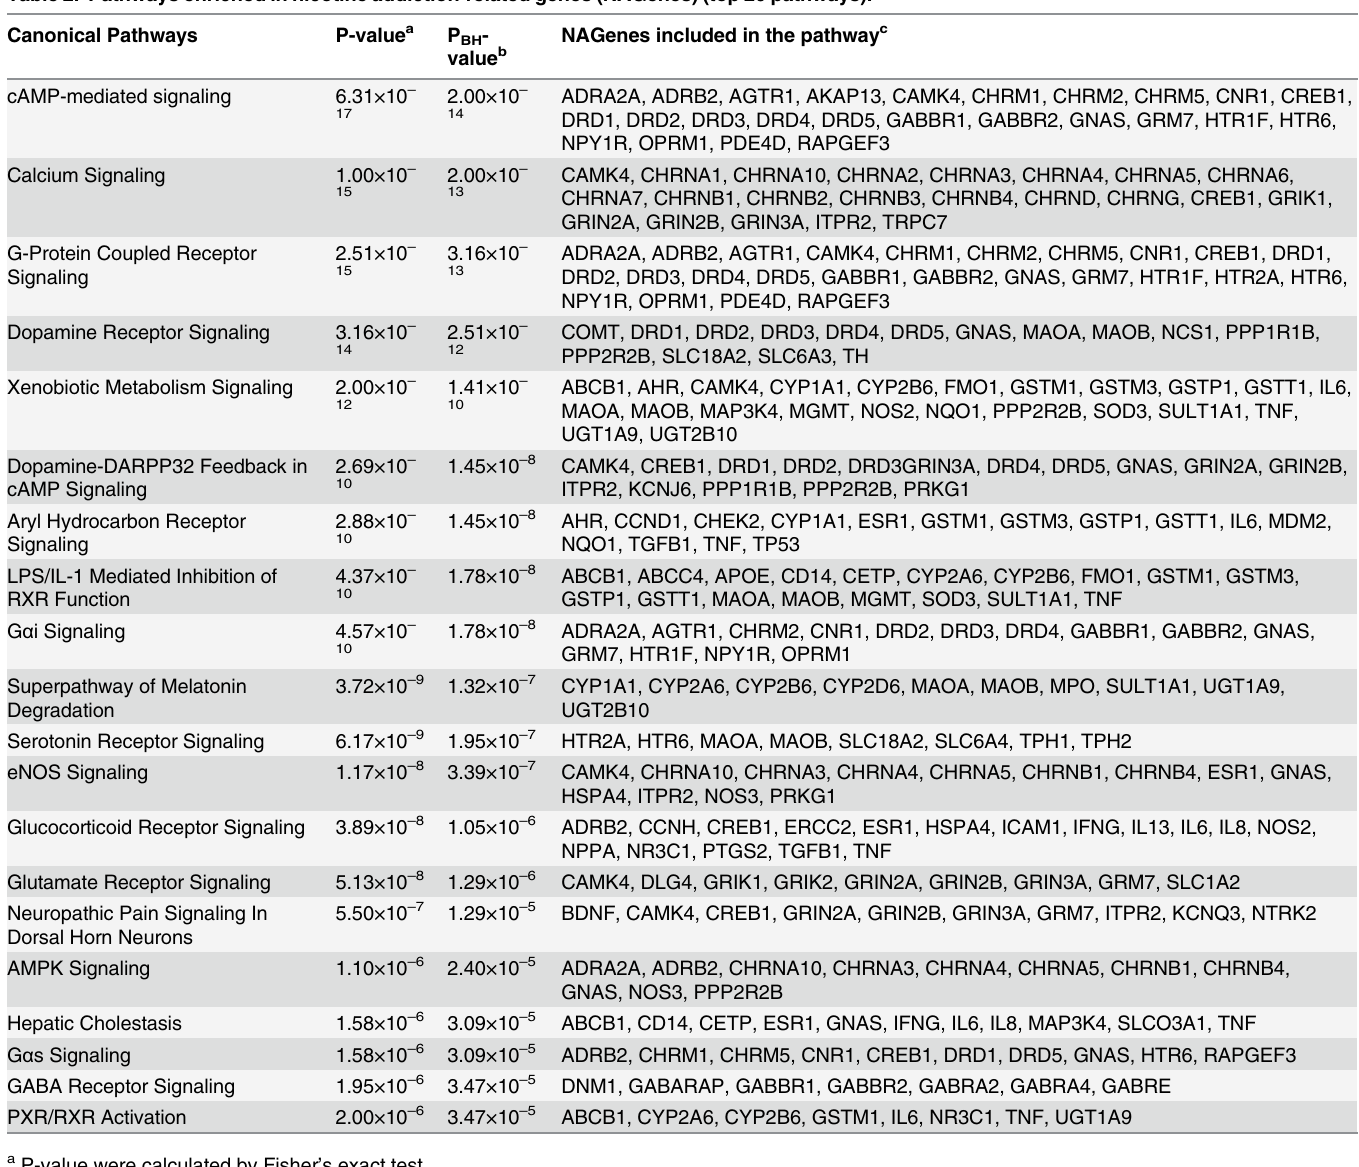
Table 2. Pathways enriched in nicotine addiction-related genes (NAGenes) (top 20